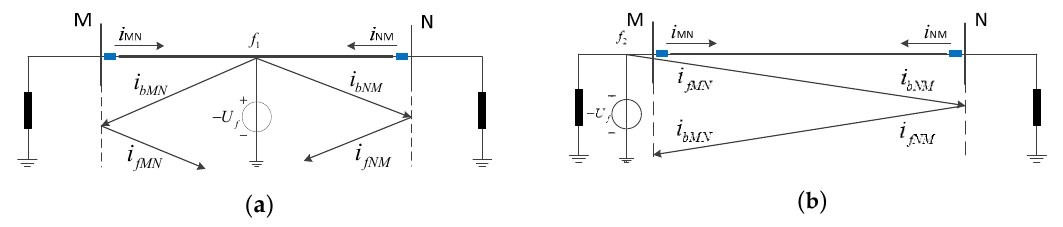
Figure 5. Propagation and reflection of fault initial traveling wave current (FITWC). ( a ) An internal fault occurs. ( b ) An external fault occurs.